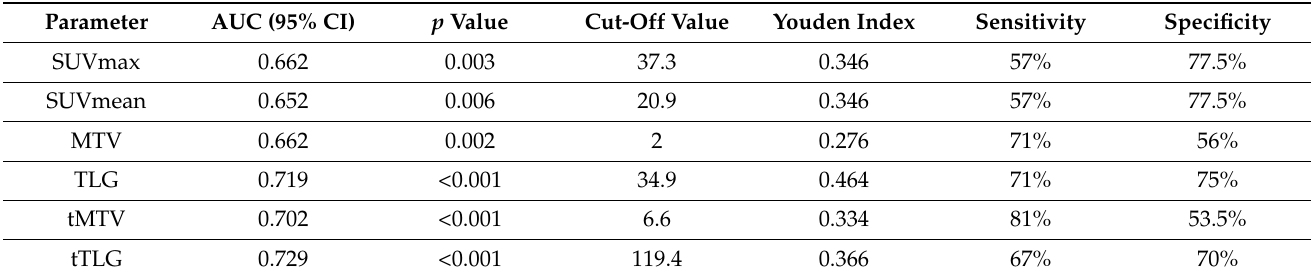
Table 2. Threshold values derived by using ROC curve analysis considering the entire population and death as final